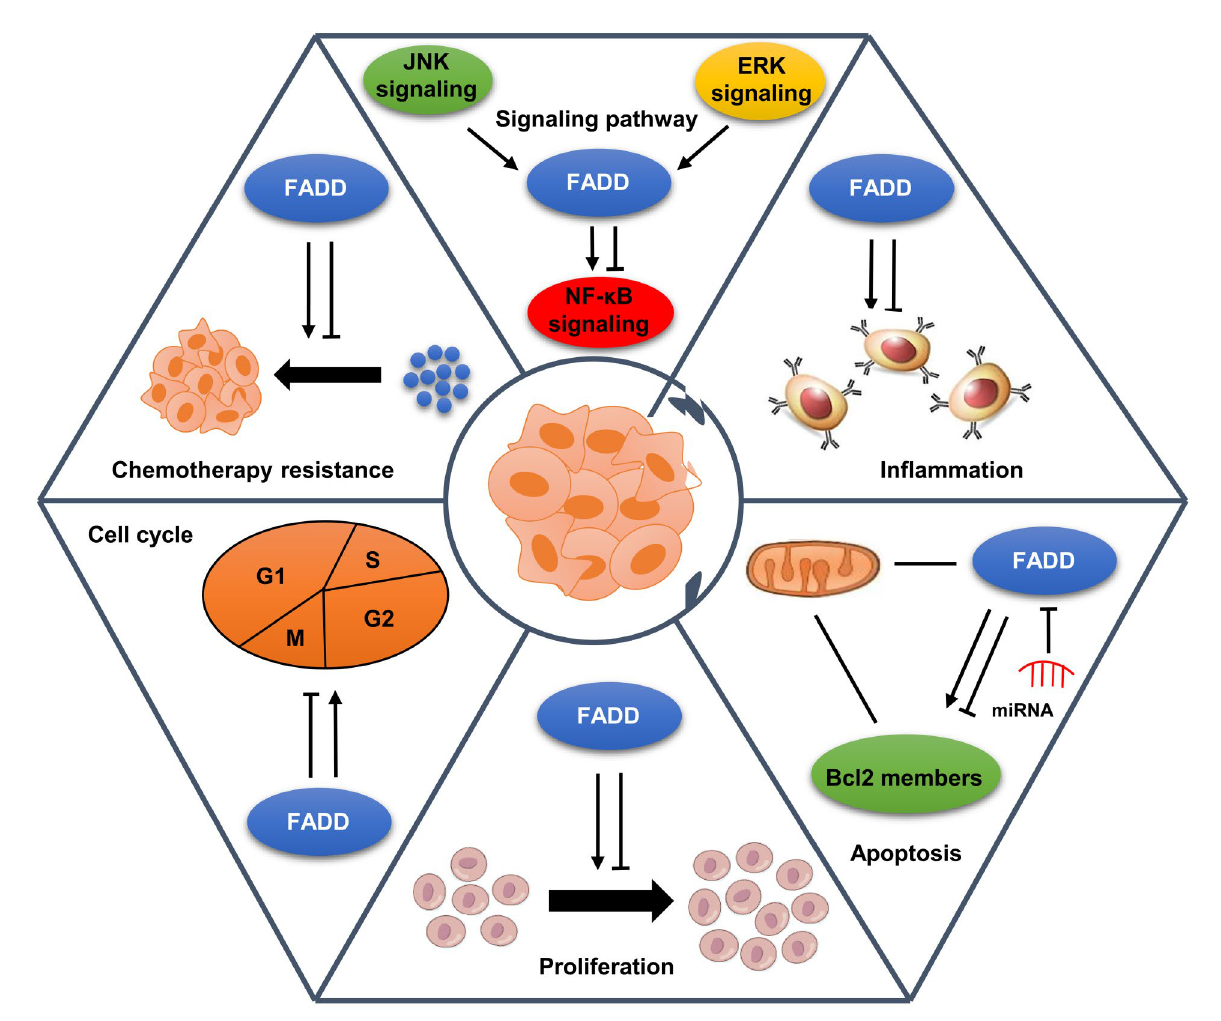
Fig. 3 Role of FADD in cancer progression. FADD dysregulation contributes to cancer progression by various mechanisms, including crosstalk with on- cogenic signaling pathway, induction of inflammation, inhibition of apoptosis, promotion of proliferation, modulation of cell cycle, and enhancement of drug